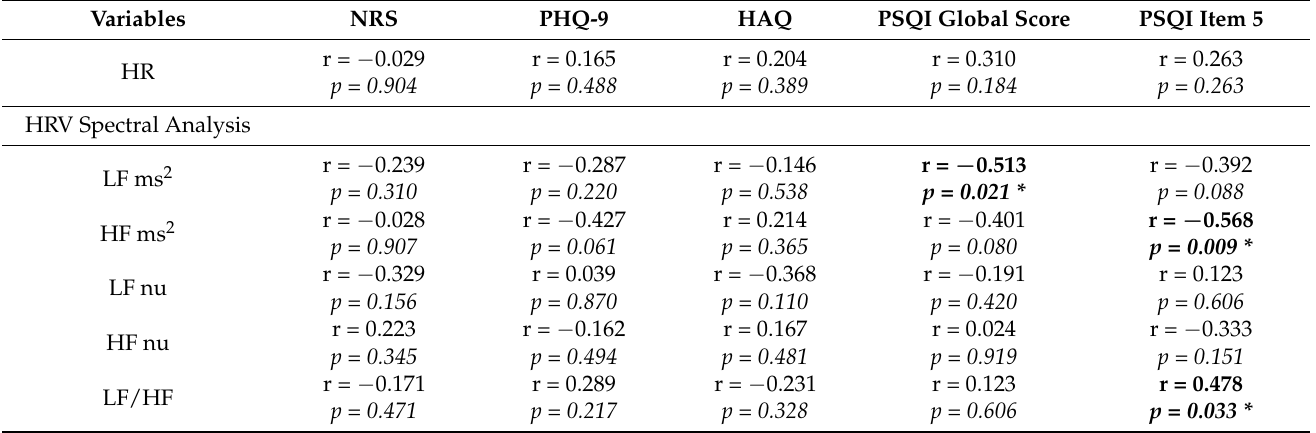
Table 3. Correlation between cardiovascular parameters and questionnaires